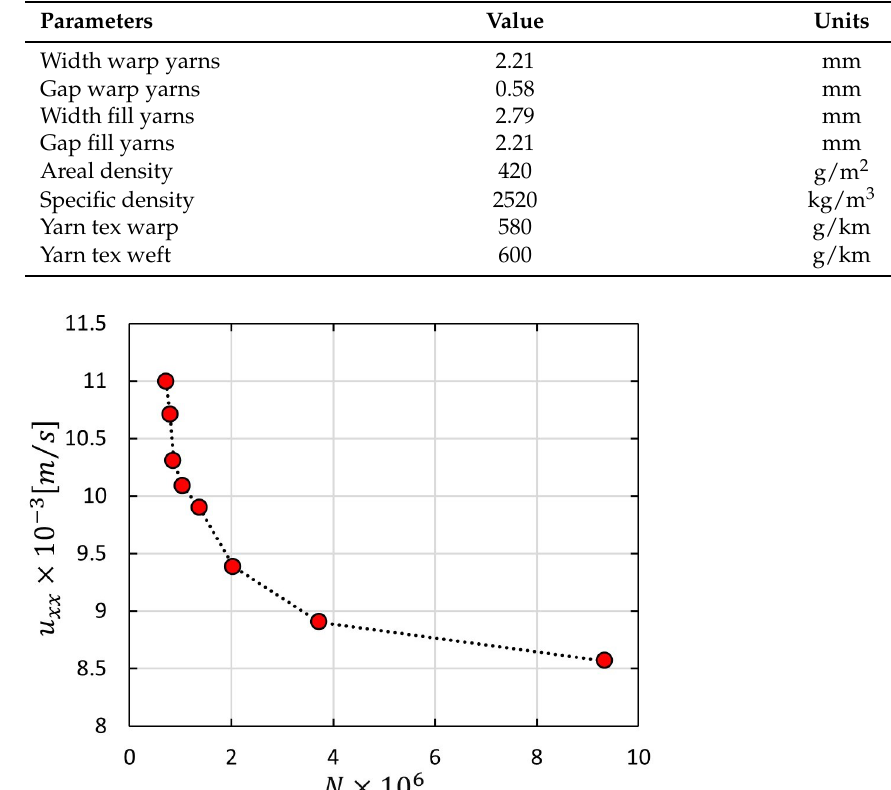
Table 2. Details of the woven fabric geometries [23].